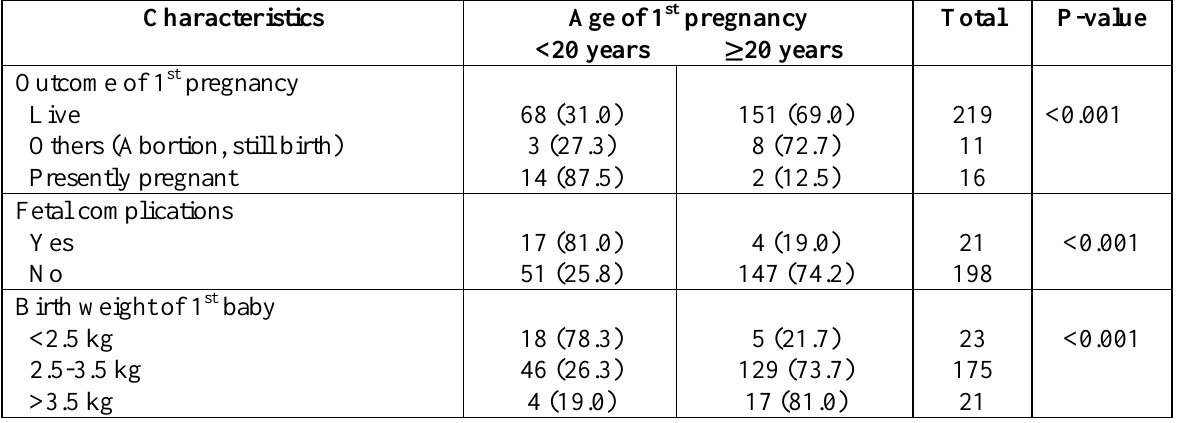
Table 3. Association between birth outcome with age of 1 st pregnancy